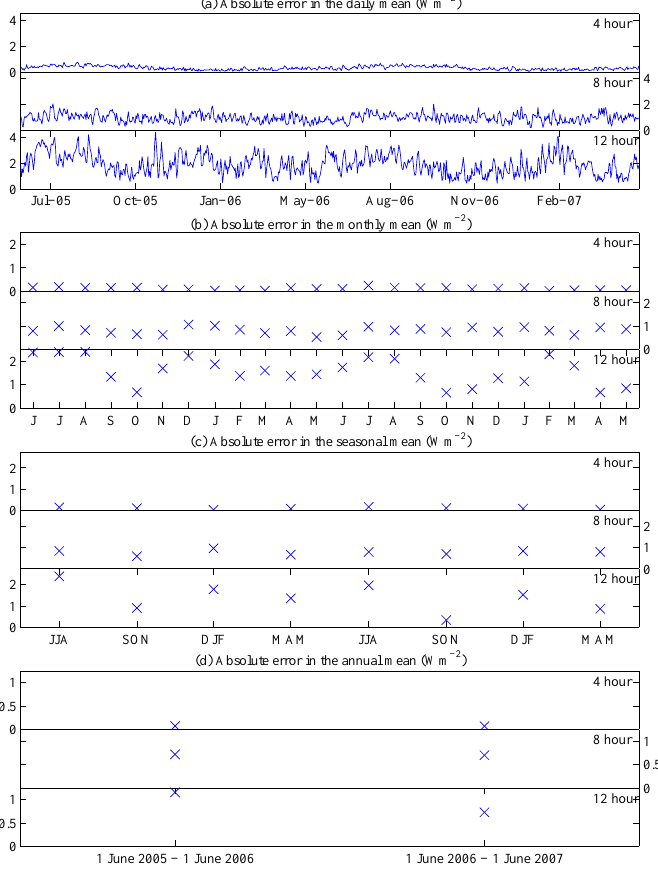
Figure 8. As for Figure 6, ( a ) daily; ( b ) monthly; ( c ) seasonal and ( d ) annual intervals, but showing just δ r , n